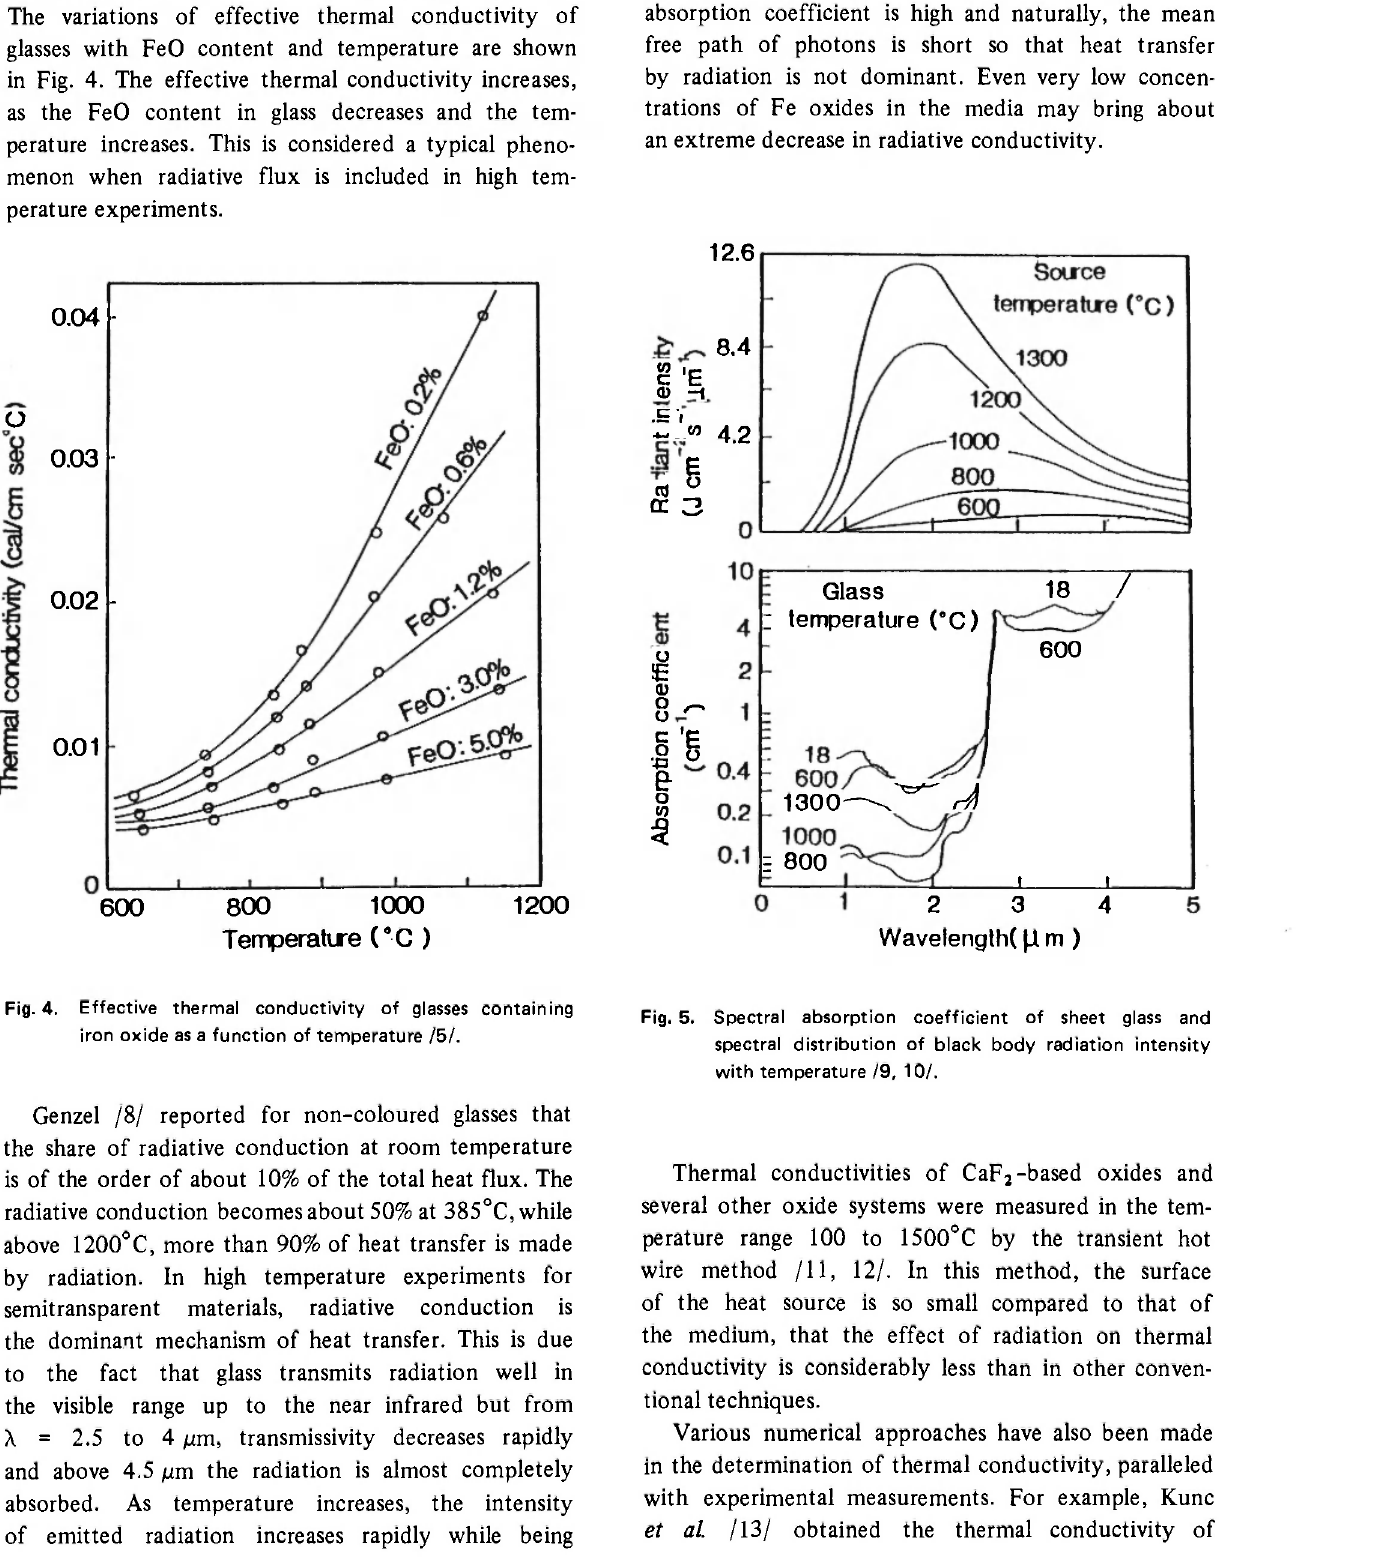
Fig. 5. Spectral absorption coefficient of sheet glass and spectral distribution of black body radiation intensity with temperature 19,